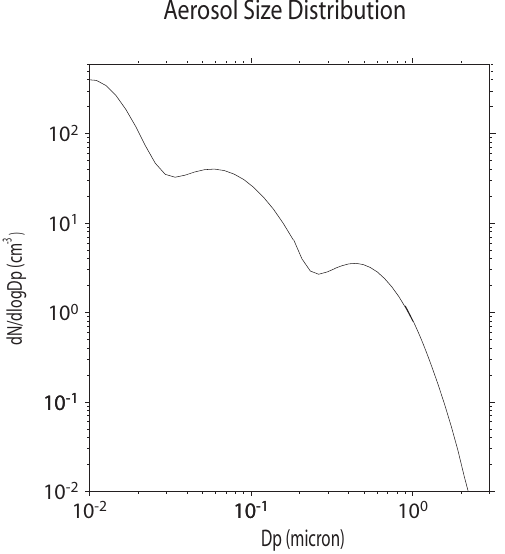
Fig. 3. Size distribution of aerosols acting at the surface. N and D p denote the number concentration and diameter of dry aerosols,